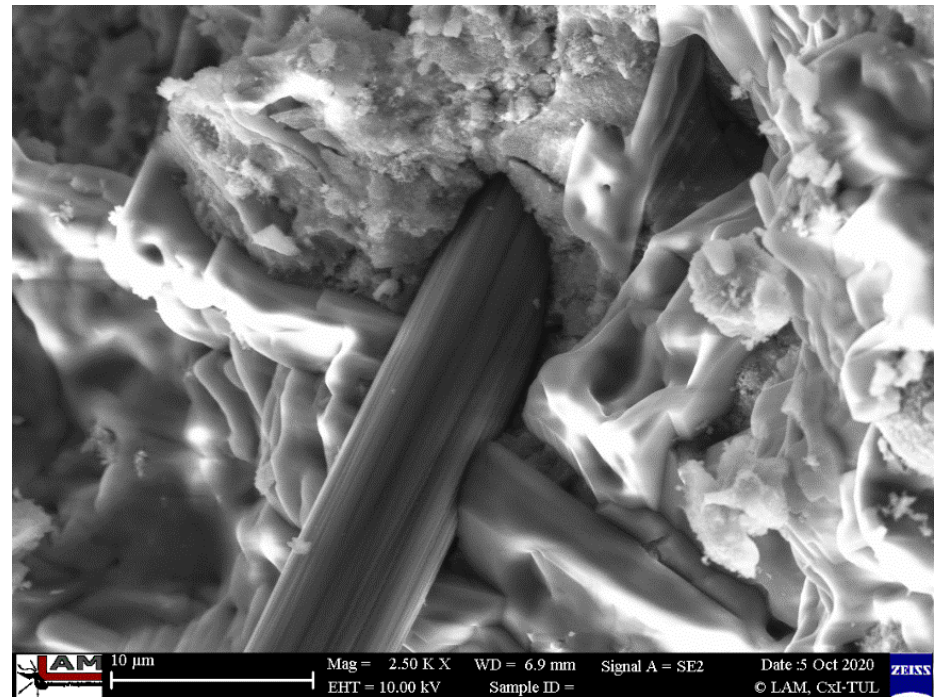
Figure 11. Microstructure of injected samples reinforced with a carbon fibers with visible lack of cohesion between the sample and the matrix.